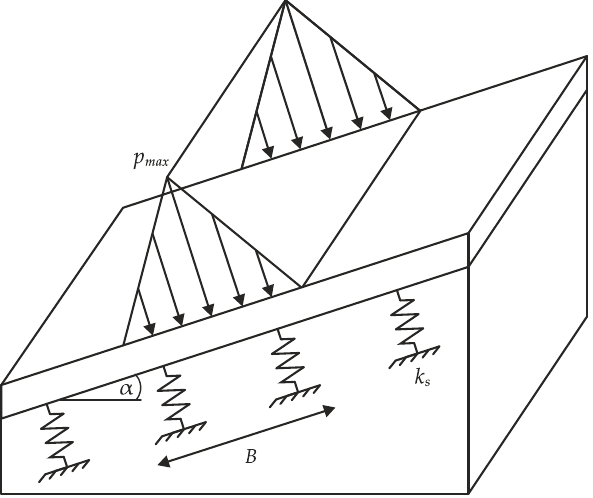
Figure 2. Plate on an elastic foundation (PEF) and wave impact load, idealized as triangular load (after [16]). Table 1. Parametrization of the wave load in the design of different kinds of monolithic or coherent revetments with a PEF model.